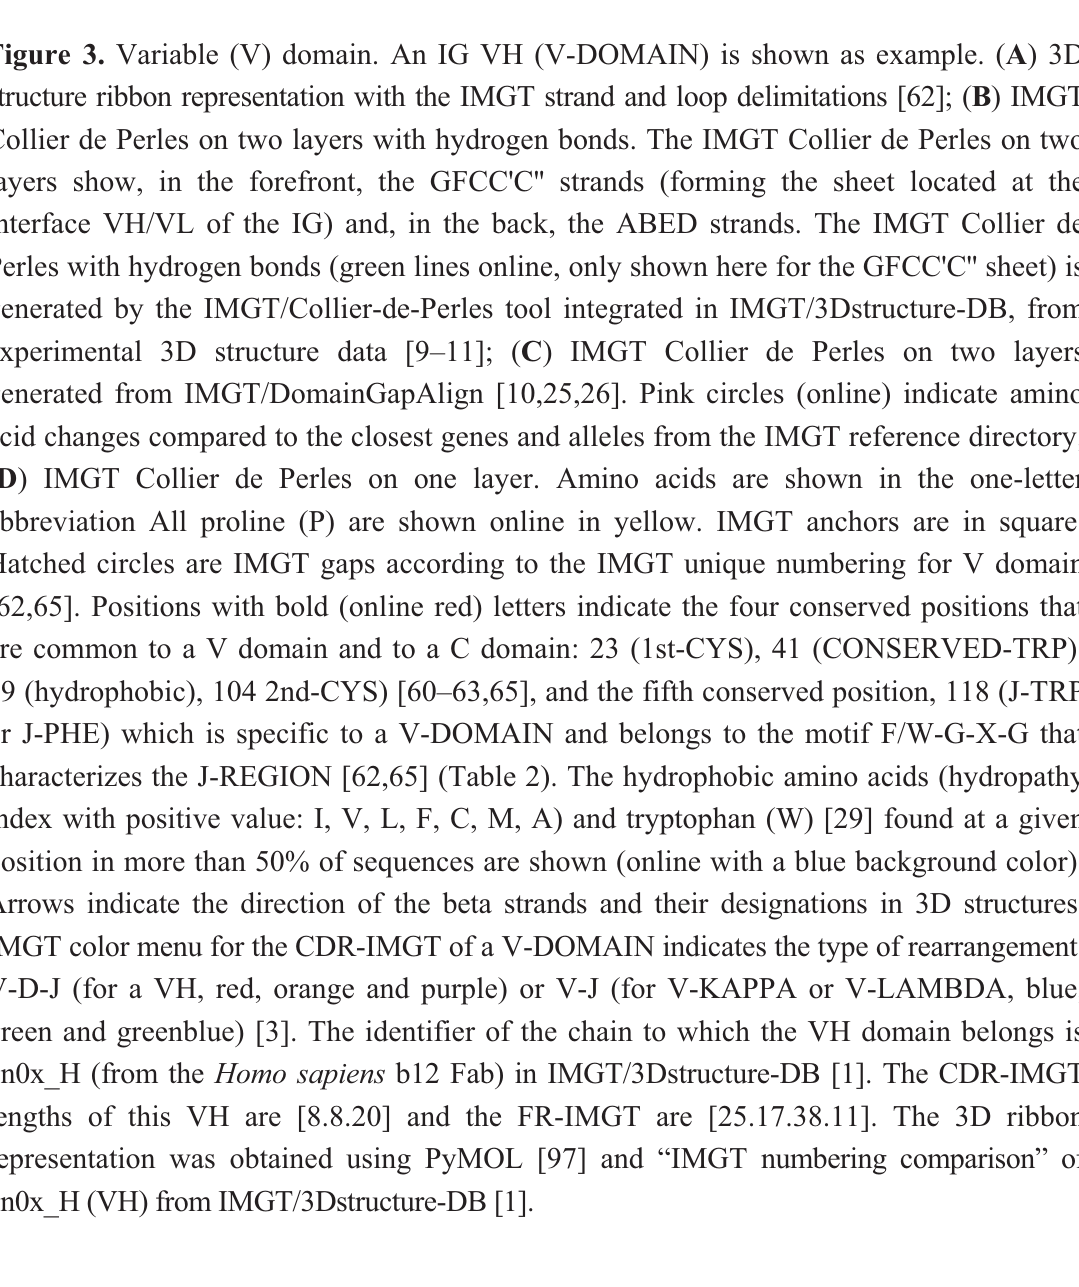
Figure 3. Variable (V) domain. An IG VH (V-DOMAIN) is shown as example. ( A ) 3D structure ribbon representation with the IMGT strand and loop delimitations [62]; ( B ) IMGT Collier de Perles on two layers with hydrogen bonds. The IMGT Collier de Perles on two layers show, in the forefront, the GFCC'C'' strands (forming the sheet located at the interface VH/VL of the IG) and, in the back, the ABED strands. The IMGT Collier de Perles with hydrogen bonds (green lines online, only shown here for the GFCC'C'' sheet) is generated by the IMGT/Collier-de-Perles tool integrated in IMGT/3Dstructure-DB, from experimental 3D structure data [9–11]; ( C ) IMGT Collier de Perles on two layers generated from IMGT/DomainGapAlign [10,25,26]. Pink circles (online) indicate amino acid changes compared to the closest genes and alleles from the IMGT reference directory; ( D ) IMGT Collier de Perles on one layer. Amino acids are shown in the one-letter abbreviation All proline (P) are shown online in yellow. IMGT anchors are in square. Hatched circles are IMGT gaps according to the IMGT unique numbering for V domain [62,65]. Positions with bold (online red) letters indicate the four conserved positions that are common to a V domain and to a C domain: 23 (1st-CYS), 41 (CONSERVED-TRP), 89 (hydrophobic), 104 2nd-CYS) [60–63,65], and the fifth conserved position, 118 (J-TRP or J-PHE) which is specific to a V-DOMAIN and belongs to the motif F/W-G-X-G that characterizes the J-REGION [62,65] (Table 2). The hydrophobic amino acids (hydropathy index with positive value: I, V, L, F, C, M, A) and tryptophan (W) [29] found at a given position in more than 50% of sequences are shown (online with a blue background color). Arrows indicate the direction of the beta strands and their designations in 3D structures. IMGT color menu for the CDR-IMGT of a V-DOMAIN indicates the type of rearrangement, V-D-J (for a VH, red, orange and purple) or V-J (for V-KAPPA or V-LAMBDA, blue, green and greenblue) [3]. The identifier of the chain to which the VH domain belongs is 1n0x_H (from the Homo sapiens b12 Fab) in IMGT/3Dstructure-DB [1]. The CDR-IMGT lengths of this VH are [8.8.20] and the FR-IMGT are [25.17.38.11]. The 3D ribbon representation was obtained using PyMOL [97] and “IMGT numbering comparison” of 1n0x_H (VH) from IMGT/3Dstructure-DB